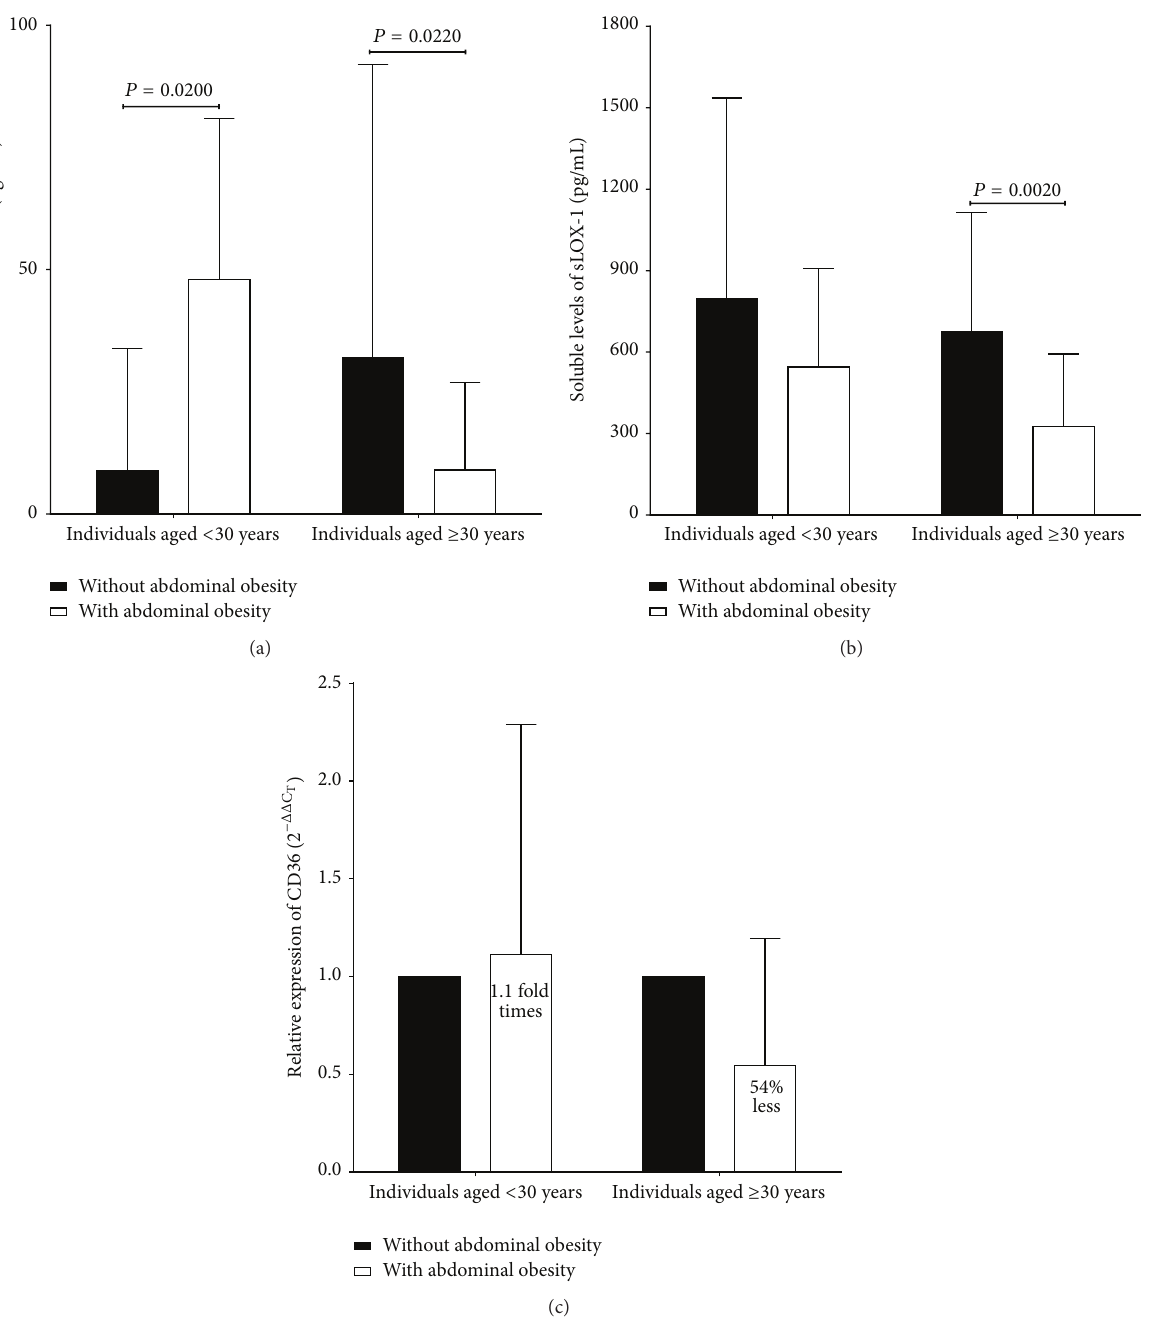
Figure 2: Scavenger receptors LOX-1 and sCD36 expression levels in study group. Subjects without abdominal obesity: 𝑛 = 86 ; subjects with abdominal obesity: 𝑛 = 54 . Data are presented as mean ± SD in individuals below 30 years of age and individuals above 30 years of age. (a) Soluble levels of CD36. (b) Soluble levels of LOX-1. (c) mRNA expression levels of CD36. LOX-1: lectin like oxidized low density lipoprotein receptor